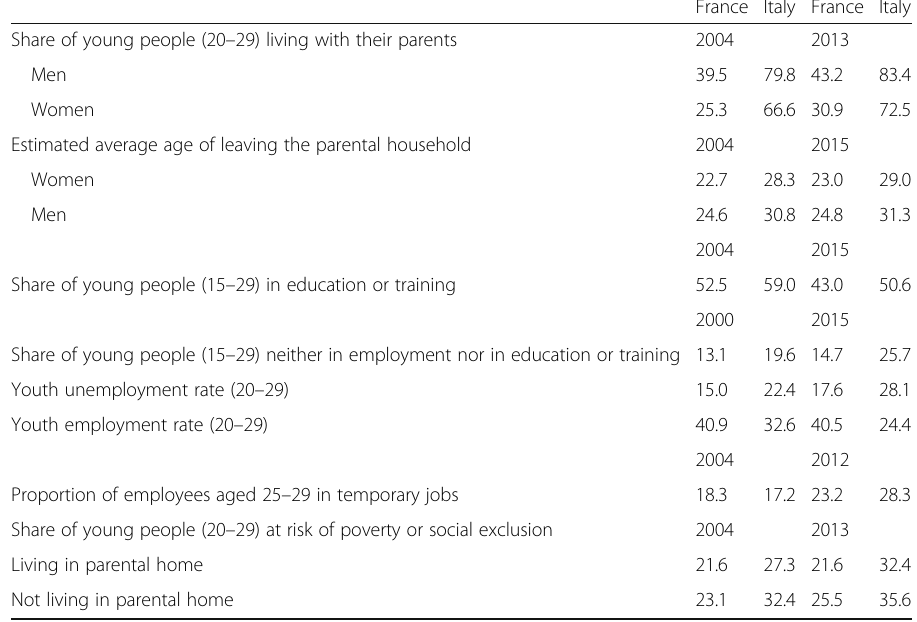
Table 8 Indicators concerning youth conditions in France and Italy in the 2000s and 2010s